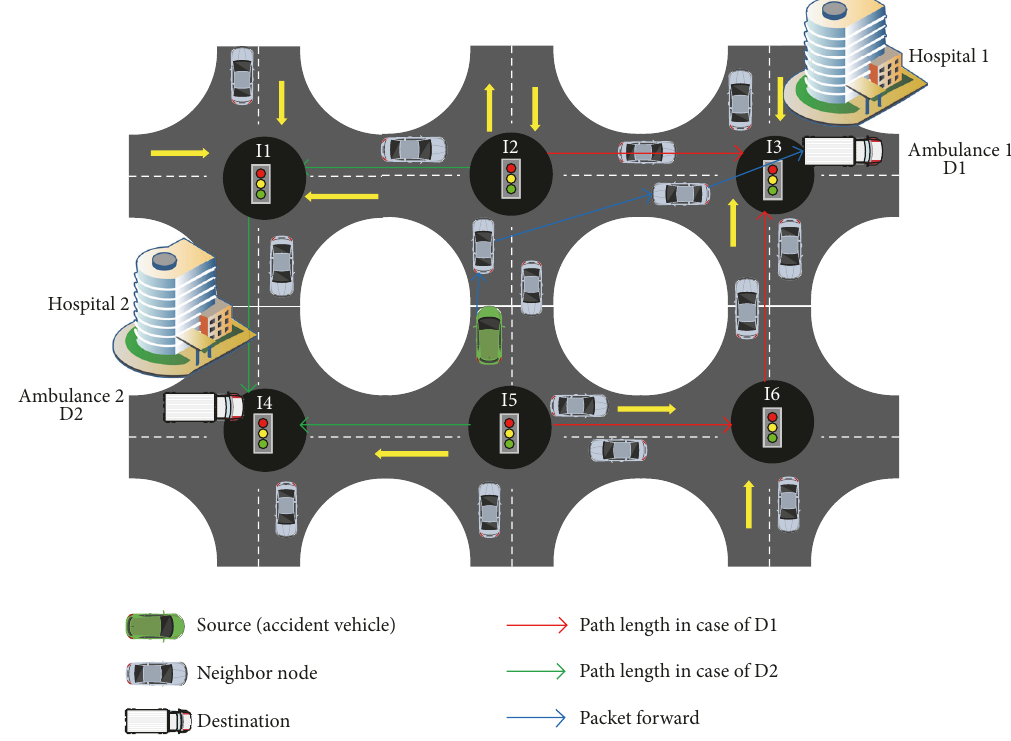
Figure 3: Source vehicle calculates the path length to